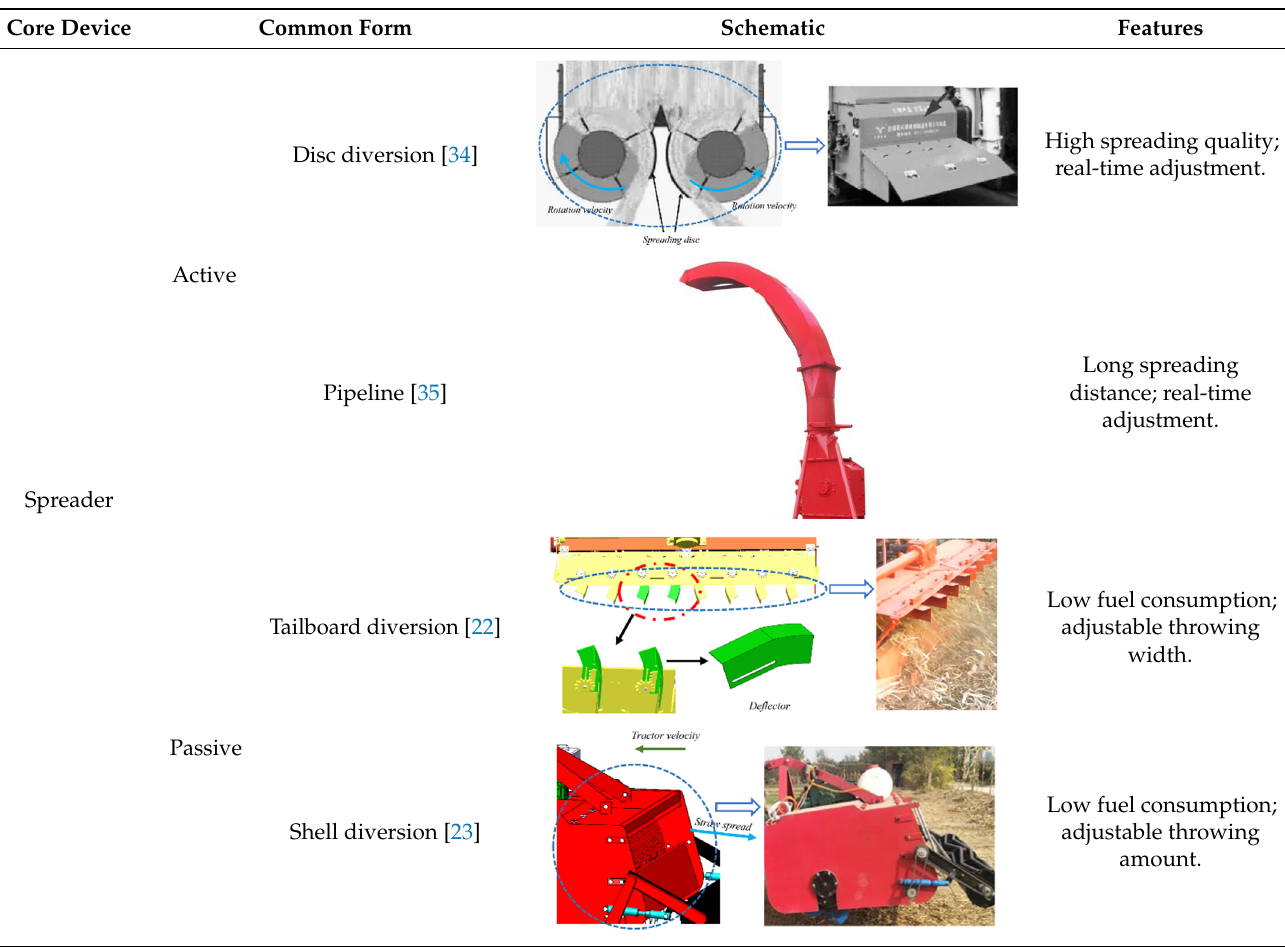
Table 5. Common types of spreaders.